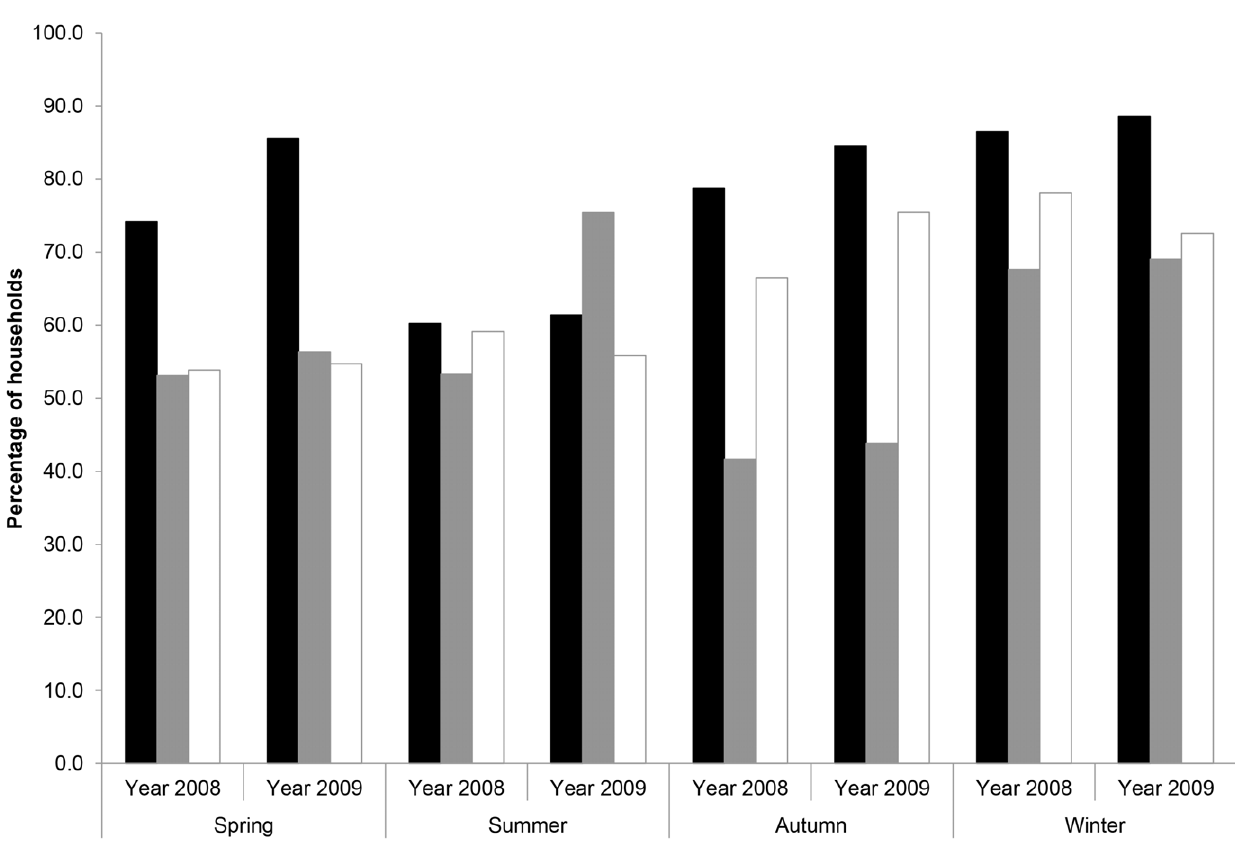
Figure 2. Percentage of single-cat (black) and multiple-cat (grey) households receiving zero prey each season, and the assumed minimum number of cats in multiple-cat households (white bars) delivering zero prey each season if prey were divided equally amongst individuals.